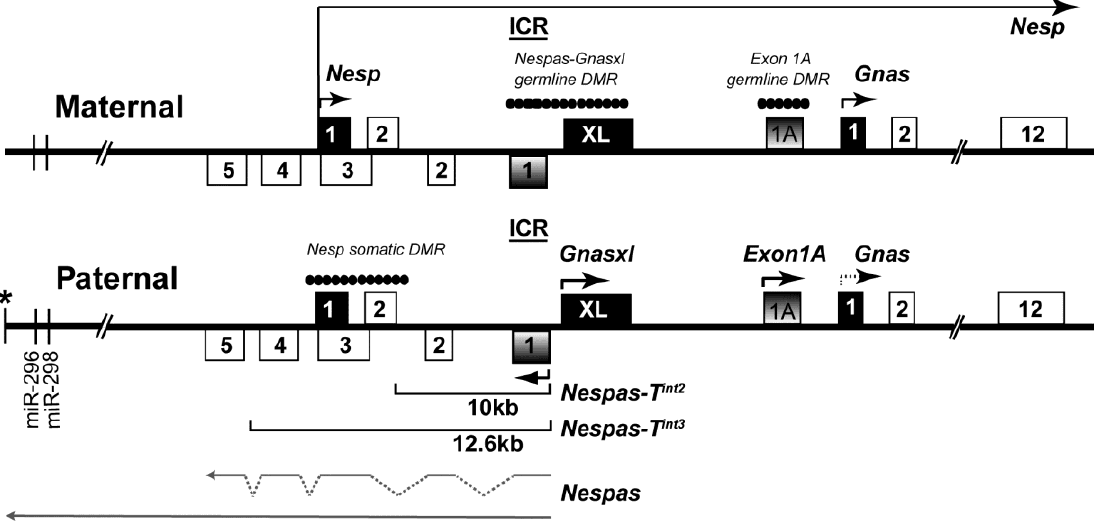
Figure 1. Organisation of the Gnas cluster. First exons of protein coding transcripts are shown as filled boxes and first exons of noncoding transcripts as shaded boxes. Arrows show the initiation and direction of transcription. Nesp is transcribed across the cluster. The arrow corresponding to the paternal Gnas allele is shown as a dotted line to indicate that the paternal Gnas allele is repressed tissue specifically. The 10 kb and 12.6 kb lines represent the new truncation mutations Nespas-T int2 and Nespas-T int3 . Nespas non-coding transcripts are shown as grey lines. * represents the termination of Nespas transcription, approximately 30 kb from the Nespas promoter. Paternally expressed microRNAs are shown as vertical lines. Filled circles represent methylated regions. ICR represents the imprinting control